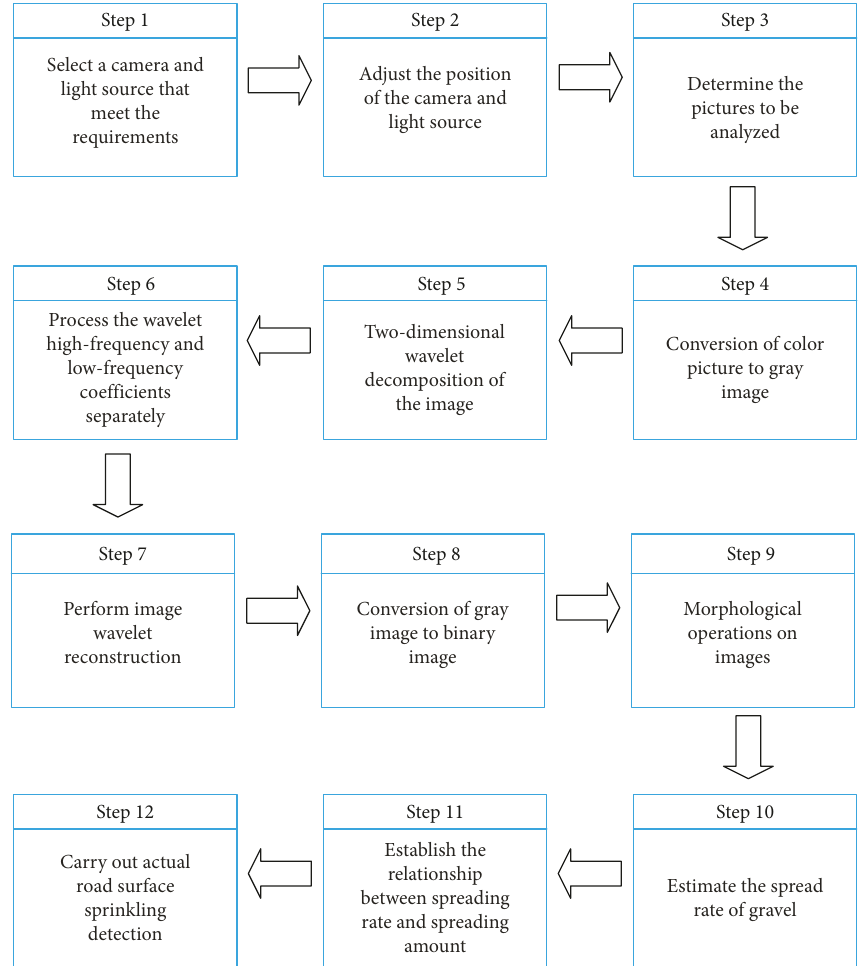
Figure 2: Flow chart of the laboratory